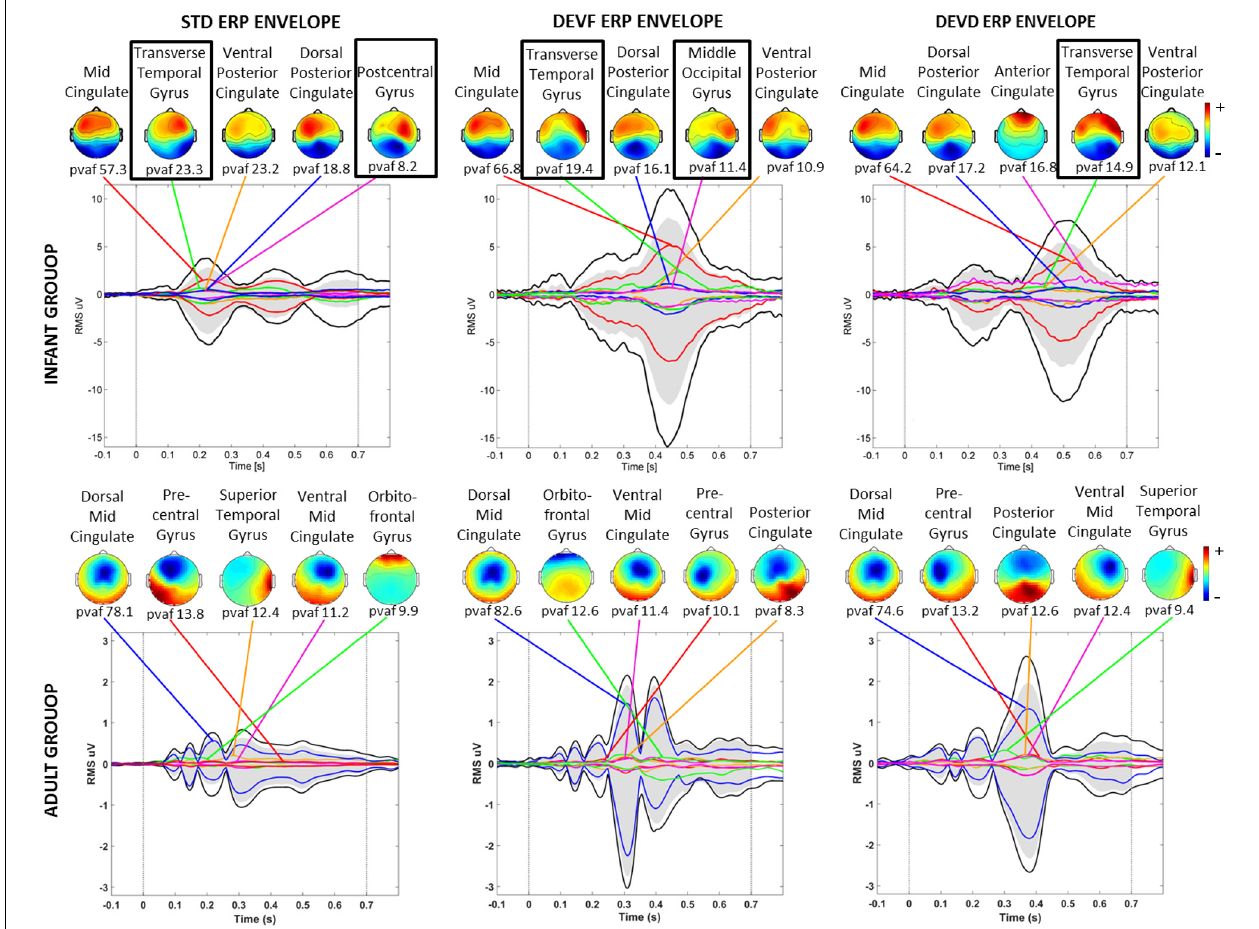
FIGURE 5 | Scalp topographies of the summed ERP projections of the most strongly contributing IC source clusters. From left to right graphs related to each stimulus type (STD, FDEV, and DDEV) are displayed. Top: infant group; bottom: adult group. For each cluster, the percent variance accounted for (pvaf) in the scalp channel ERP is shown below its scalp map. Black traces in each graph show the envelope (the most positive and negative single-channel values at each latency) of the grand-average scalp channel ERP. Upper and lower edges of the gray areas represent the envelope of the summed contributions of the five contributing clusters. Colored traces show the envelopes of the summed cluster-IC scalp projections. Black boxes identified bilateral clusters.